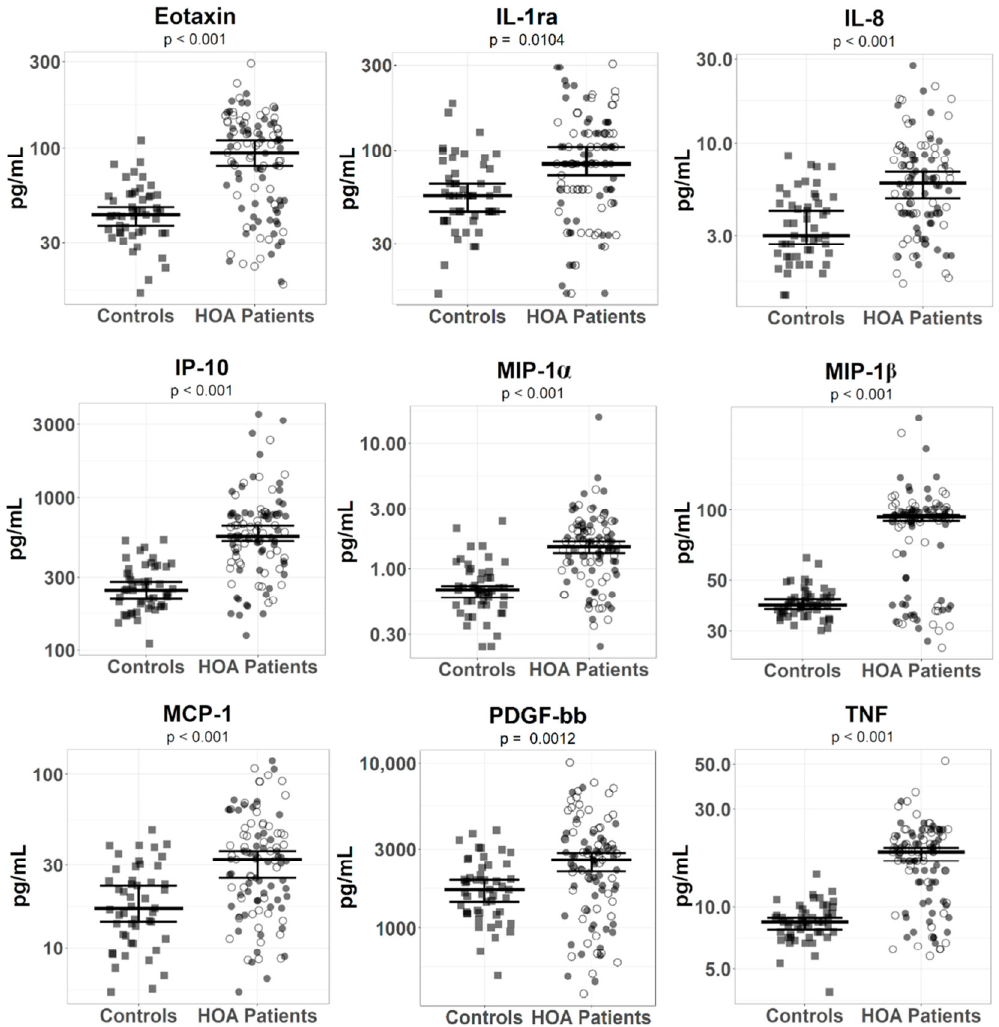
Figure 1. Serum levels of inflammatory mediators in patients with hand osteoarthritis and in healthy controls. The error bars represent 95% confidence intervals with the median calculated by a bootstrapped method with 50,000 simulations for healthy controls and HOA patients. p -values (depicted below mediators’ names) show statistical significance between healthy controls and HOA patients and were computed by the permutation test with 50,000 simulations. Healthy controls and erosive and non-erosive HOA patients are depicted as filled squares and filled and unfilled circles,